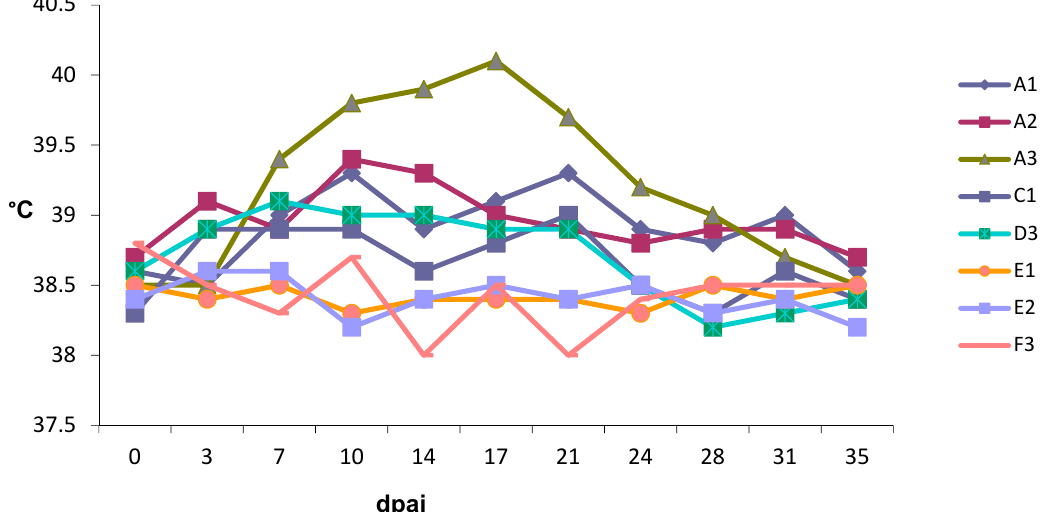
Figure 3. The body temperature of heifers infected with BTV-8 contaminated semen from natural-infected bulls until 35 days post-artificial insemination (dpai); thereafter, temperature remained normal.